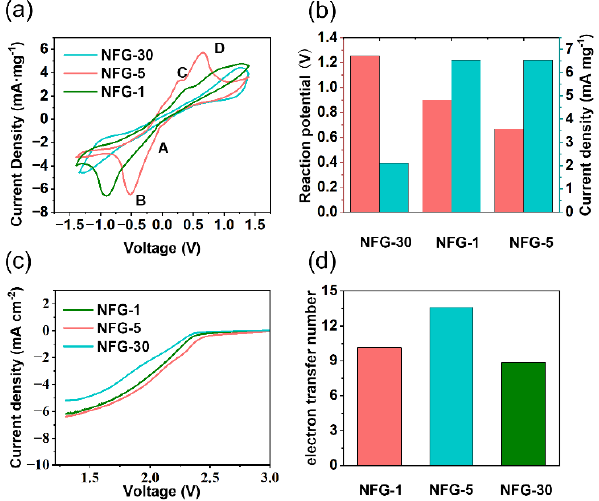
Figure 3. ( a ) CVs of symmetric cells with NFG-1, NFG-5, and NFG-30 electrodes. ( b ) Peak D’s potentials and current densities. ( c ) NiFeLDH/rGO linear sweep voltammetry curves in the direction of SRR. ( d ) An electron transfer n number comparison among NFG-30, NFG-5, and NFG-1 electrodes.